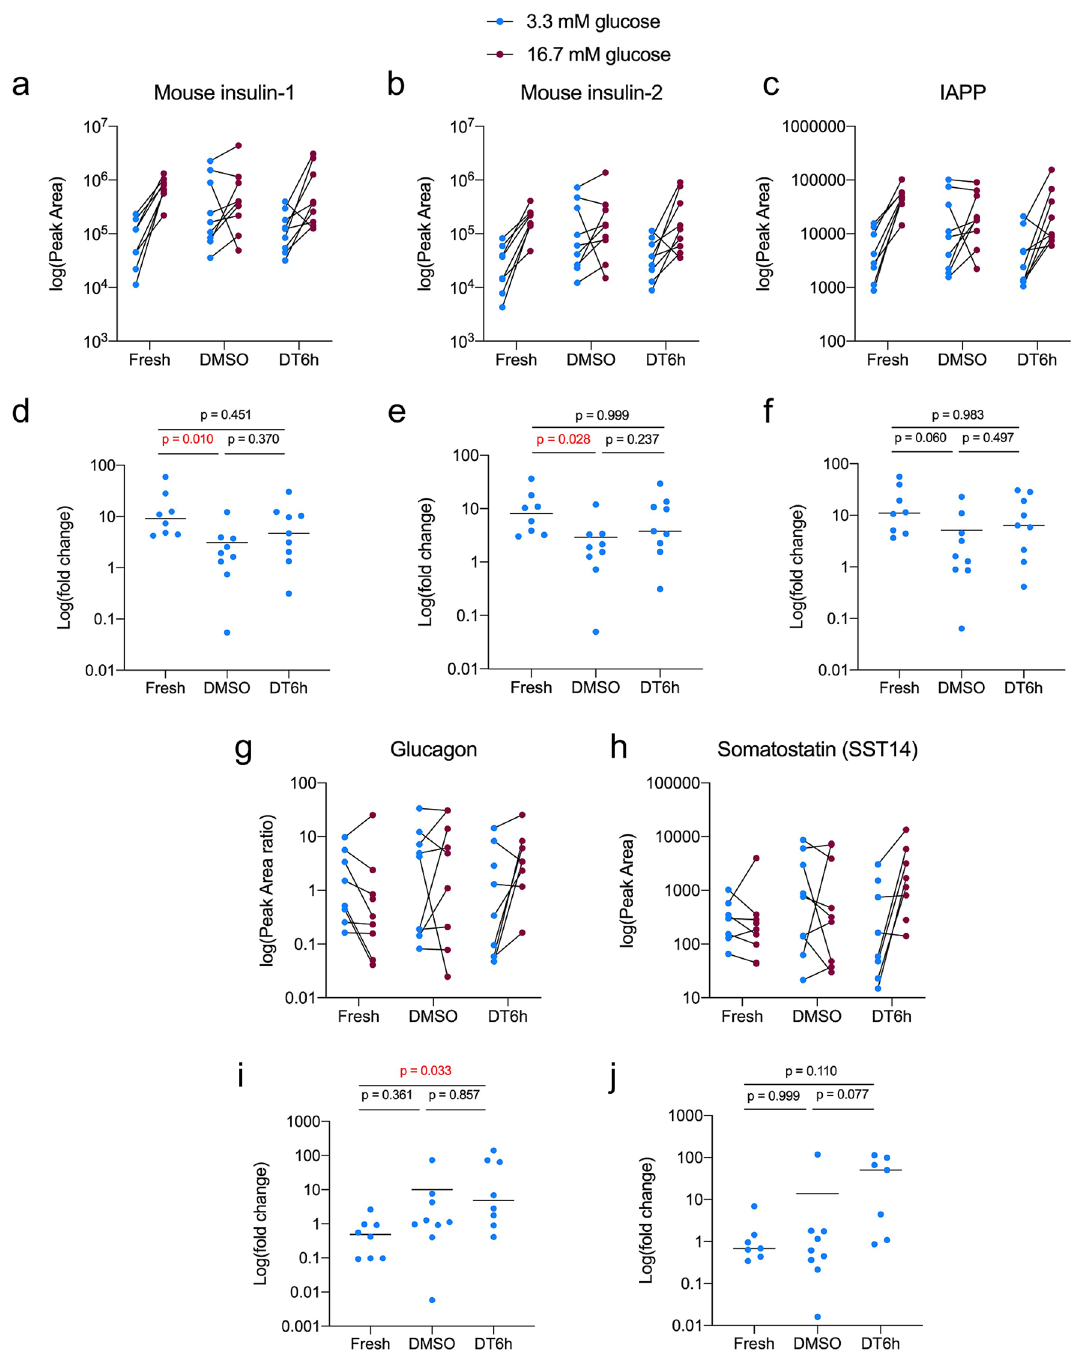
Figure 6. Peptide production by islets after glucose stimulation. Peptide levels measured by LC–MS/MS for ( a ) mouse insulin-1, ( b ) mouse insulin-2 and ( c ) islet amyloid polypeptide (IAPP). Fold changes calculated as the ratio of Peak Area measured in 16.7 mM glucose and in 3.3 mM glucose for ( d ) mouse insulin-1, ( e ) mouse insulin-2, ( f ) islet amyloid polypeptide (IAPP). Peptide levels measured by LC–MS/MS for ( g ) glucagon and ( h ) somatostatin (SST-14). Fold changes calculated as the ratio of Peak Area concentration measured in 16.7 mM glucose and in 3.3 mM glucose for ( i ) glucagon and ( j ) somatostatin (SST-14). Peak Areas for glucagon were normalised to Peak Areas for glucagon internal standard. One-way Kruskal–Wallis analysis of variance was performed for the fold changes followed by Dunn’s correction for multiple comparisons (n = 9 samples from 3 isolations, each sample = 10 islets; p-values are shown for each comparison, significant differences are highlighted in red). All figures were produced in GraphPad Prism (version 8.4.1, https:// www. graph pad.